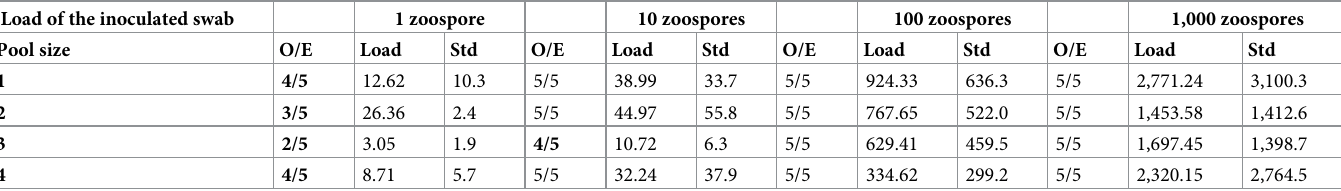
Table 1. Zoospore counts for Experiment 1.